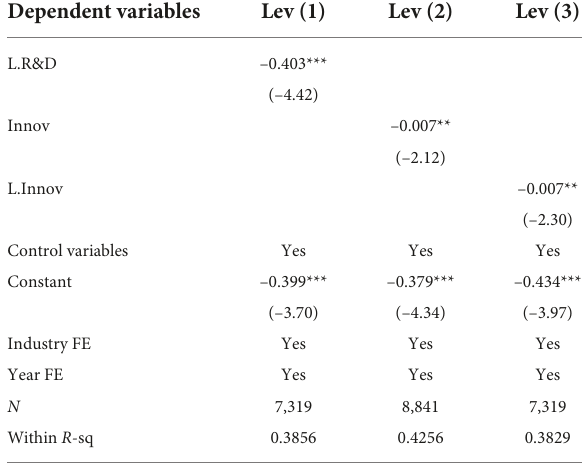
TABLE 8 The results of the instrumental variables approach to regression.